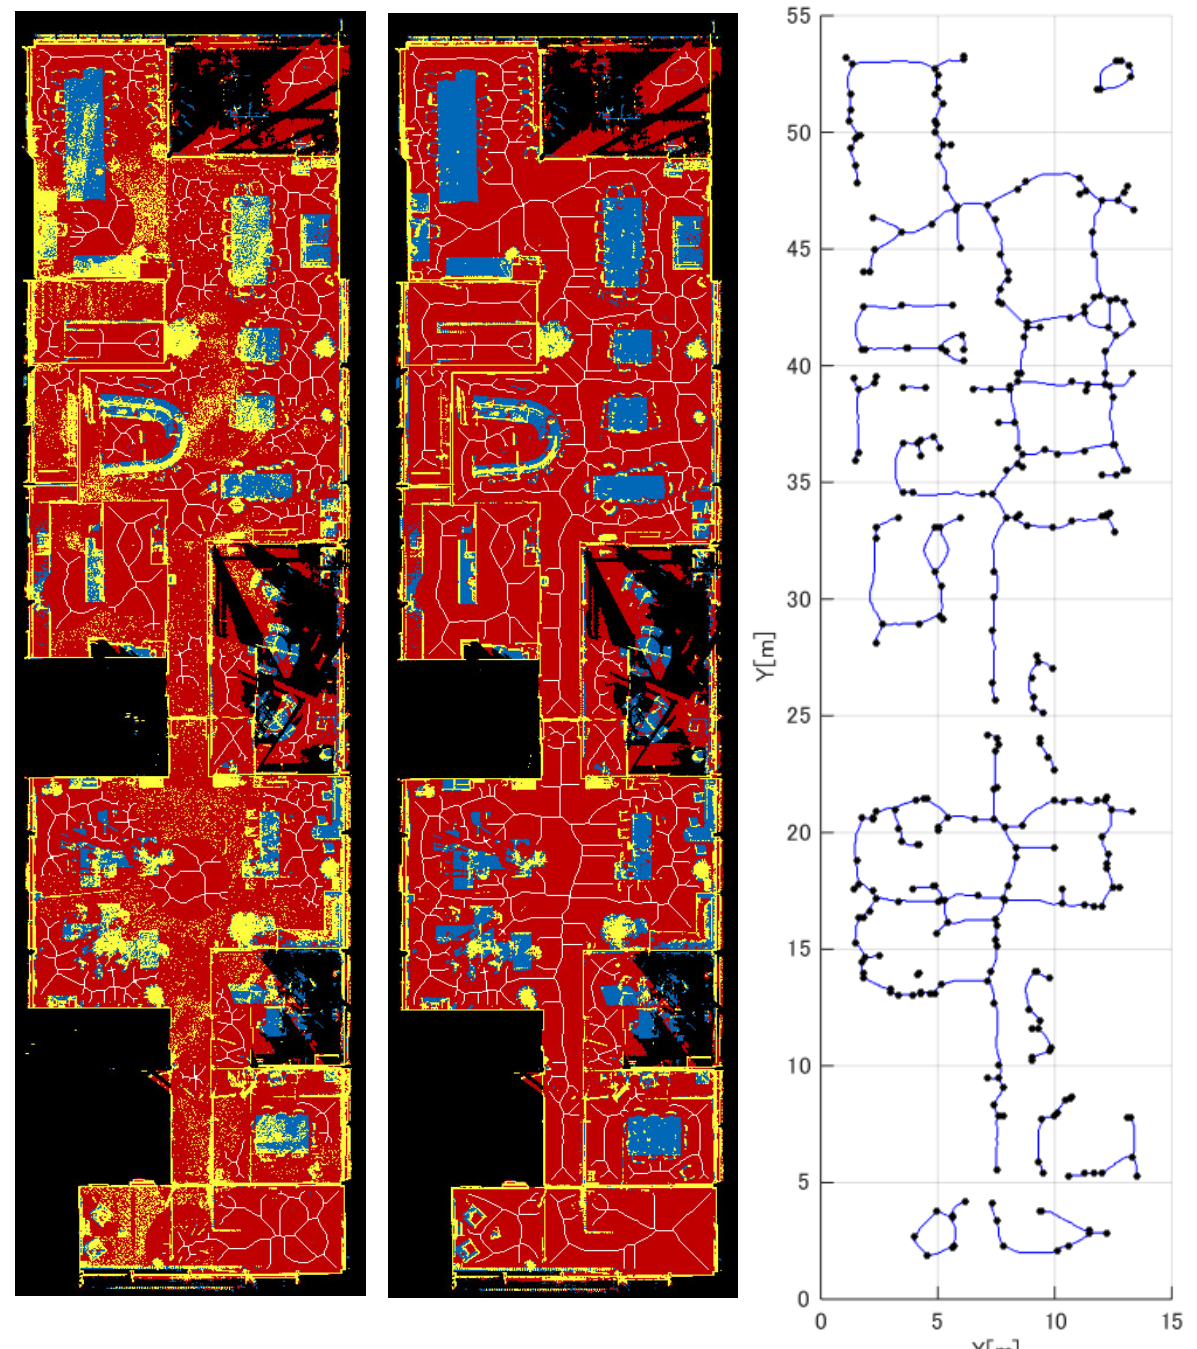
Figure 11. Improvement after pedestrian noise filtering (left image: object classification and geometrical network generation result using non-filtered point clouds; center image: object classification and geometrical network generation result using filtered point clouds; right image: geometrical network model using filtered point